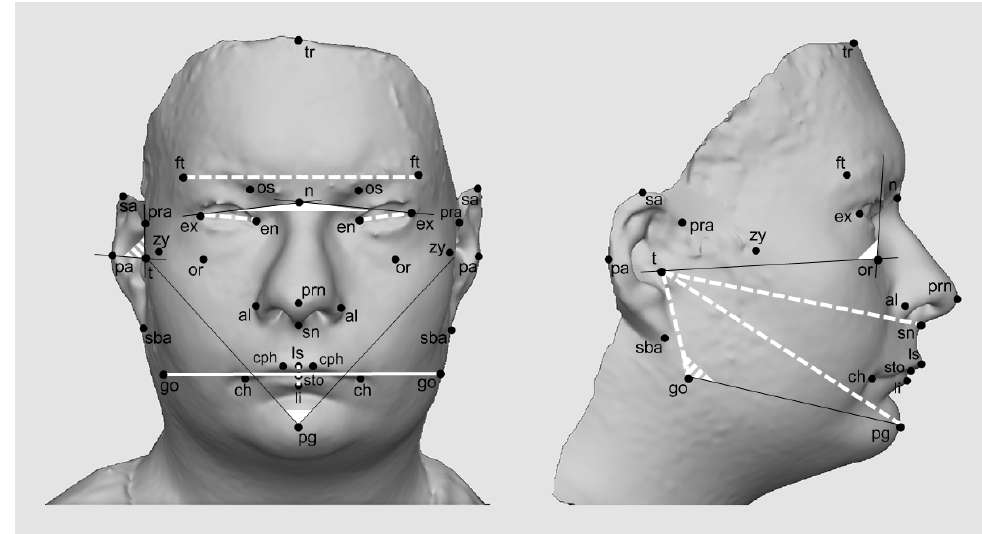
Figure 1 . 3D facial image of a subject with PWS. Black dots correspond to the anatomical landmarks used in the study; landmarks are associated with their acronyms. Anthropometric measurements with remarkable differences from healthy subjects (mean z score ≥ |1|) are highlighted. Dotted lines and angles: decreased measurements. Continuous lines and angles: increased measurements. Table 2 . 3D anthropometric measurements describing the face in toto in subjects with PWS as compared to healthy subjects.